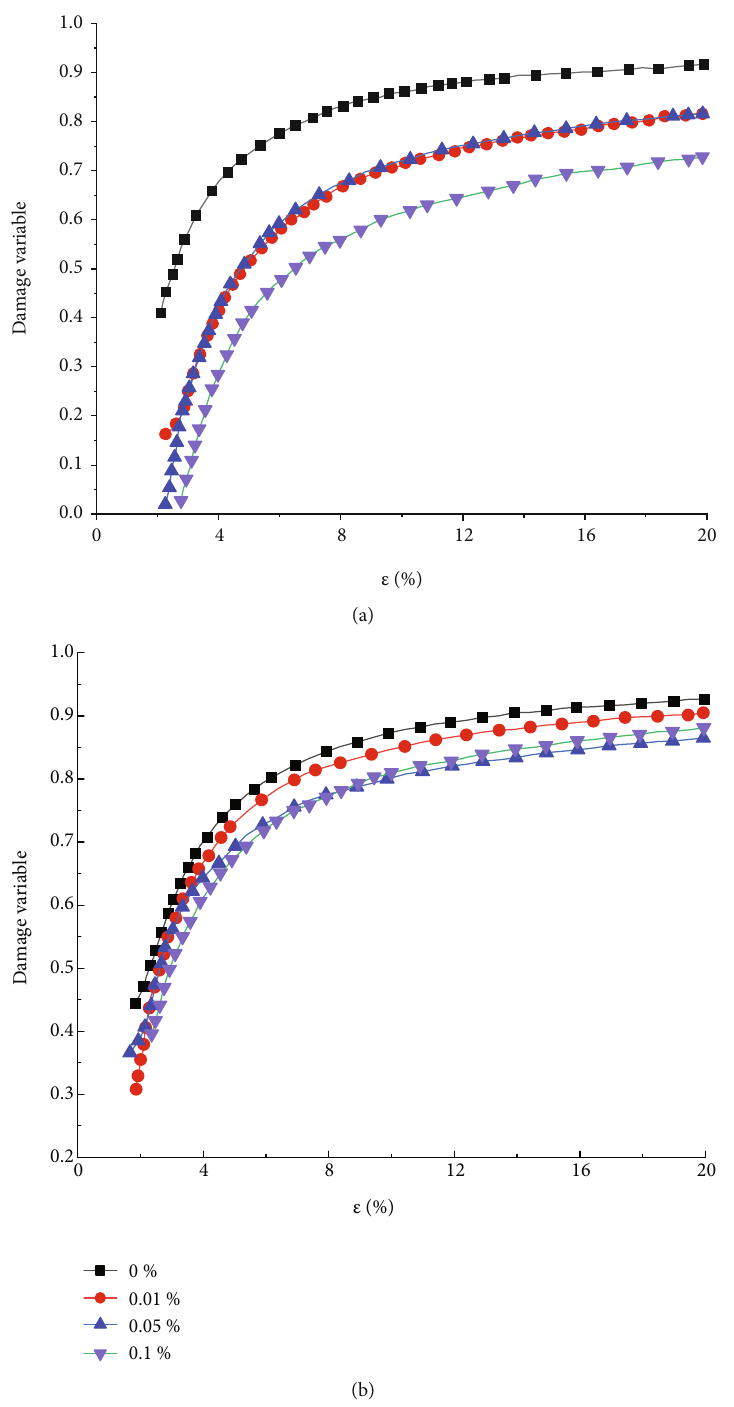
Figure 8: Comparison curves of damage variables under di ff erent chromium ion concentrations. (a) The initial dry density is 1.45g/cm 3 , 100kPa. (b) The initial dry density is 1.45g/cm 3 ,